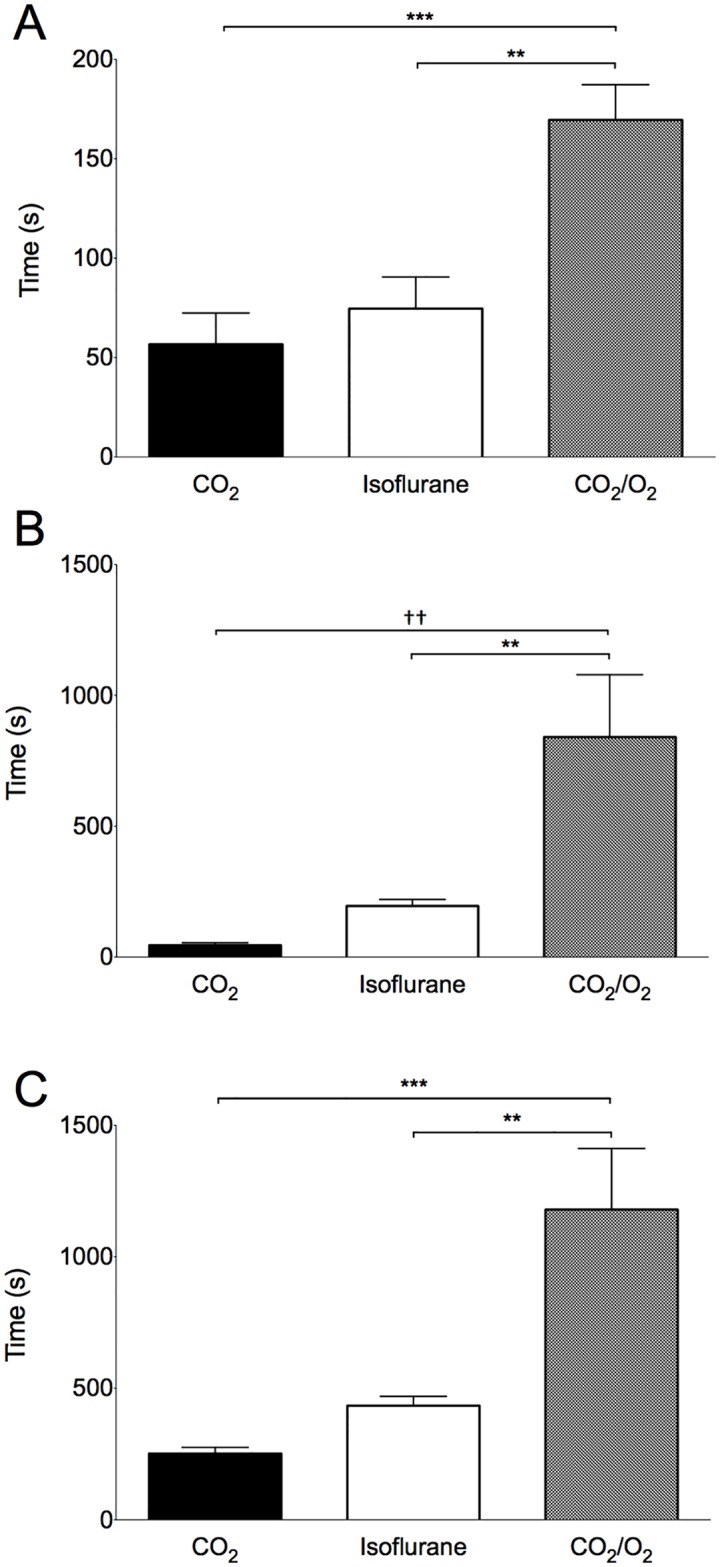
Time periods during which differences between treatment groups emerged.A: Time from loss of the righting reflex until an isoelectric electrocorticograph. *** p = 0.0002, ** p = 0.002. B: Time from an isoelectric electrocorticograph until apnea. †† p = 0.002, ** p = 0.01. C: Time from baseline until apnea. ** p = 0.003, *** p = 0.0003. CO2, carbon dioxide. CO2/O2, carbon dioxide/oxygen. Data are mean ± SEM.